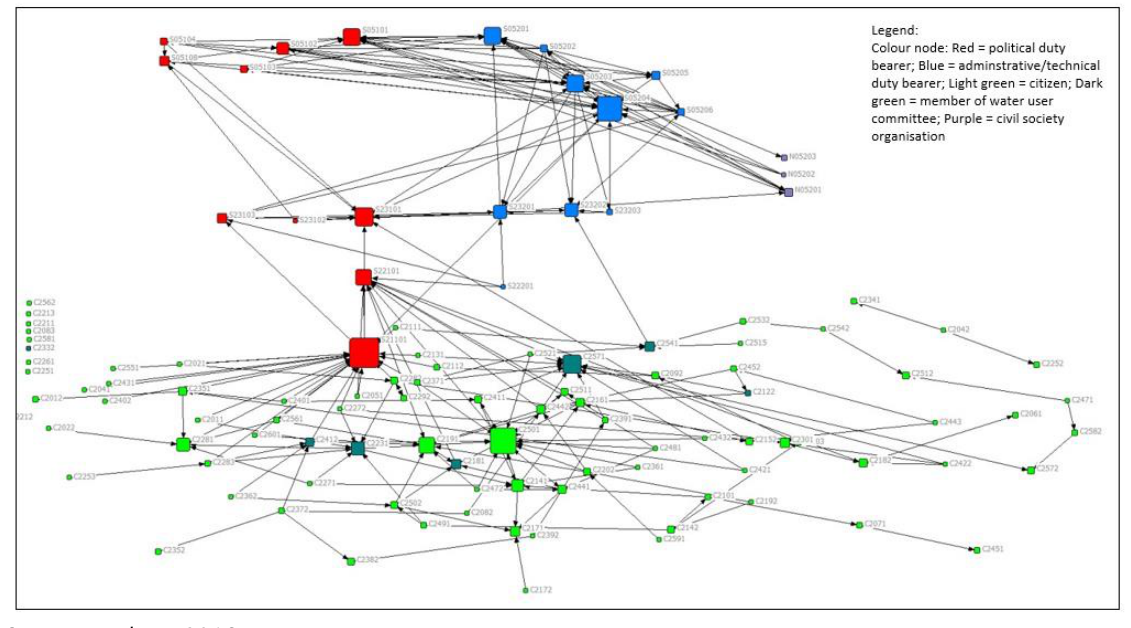
Figure 5: Information-sharing network among duty bearers and citizens